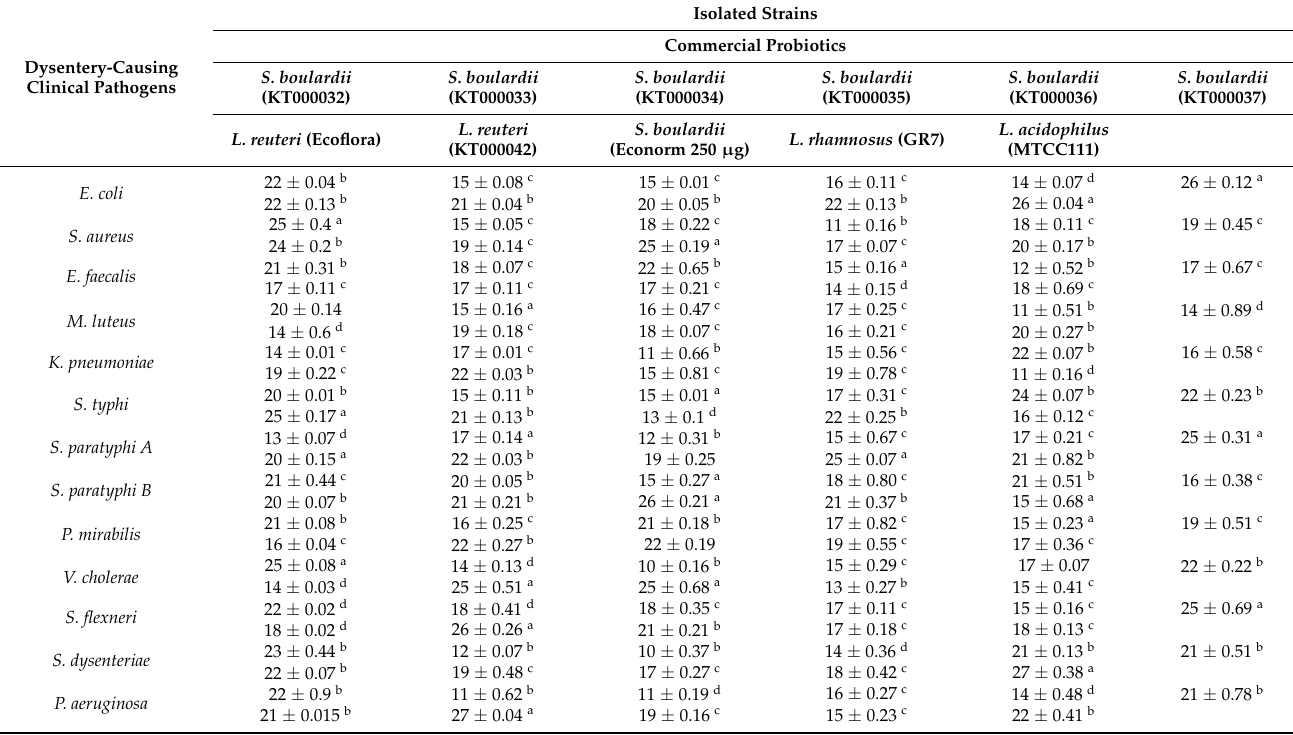
Isolated Strains Commercial